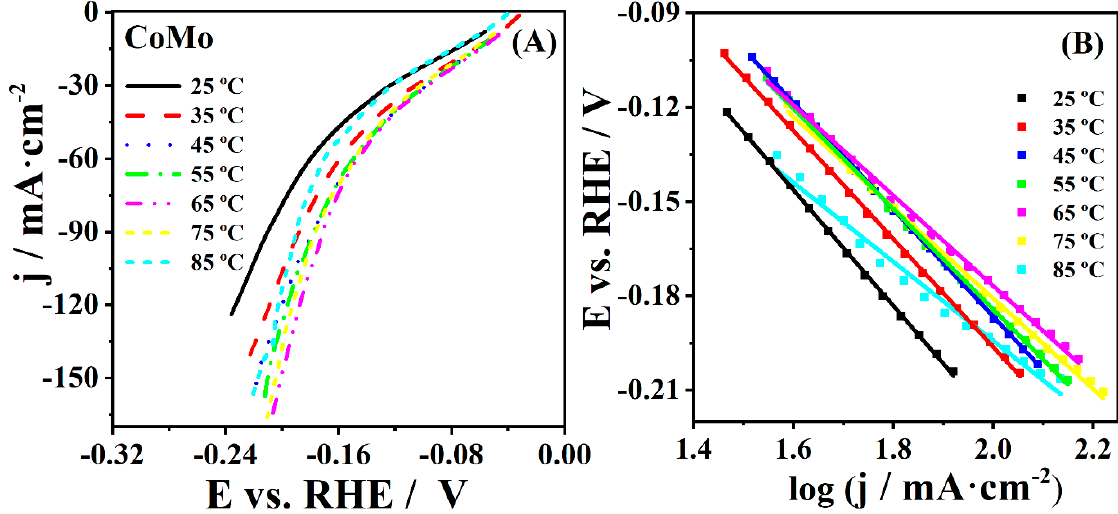
Figure 3. ( A ) HER polarization curves of CoMo coatings in 1 M KOH recorded at polarization rate of 5 mV·s − 1 at different temperatures with ( B ) corresponding Tafel plots.